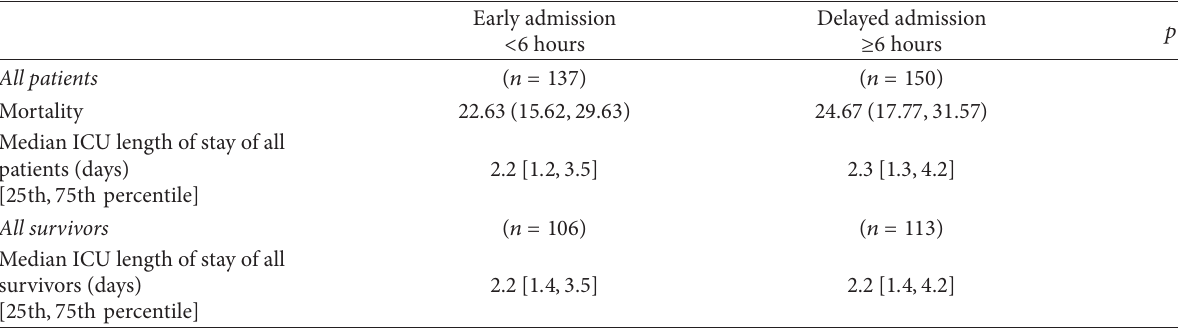
Table 2: Survival and ICU length of stay.